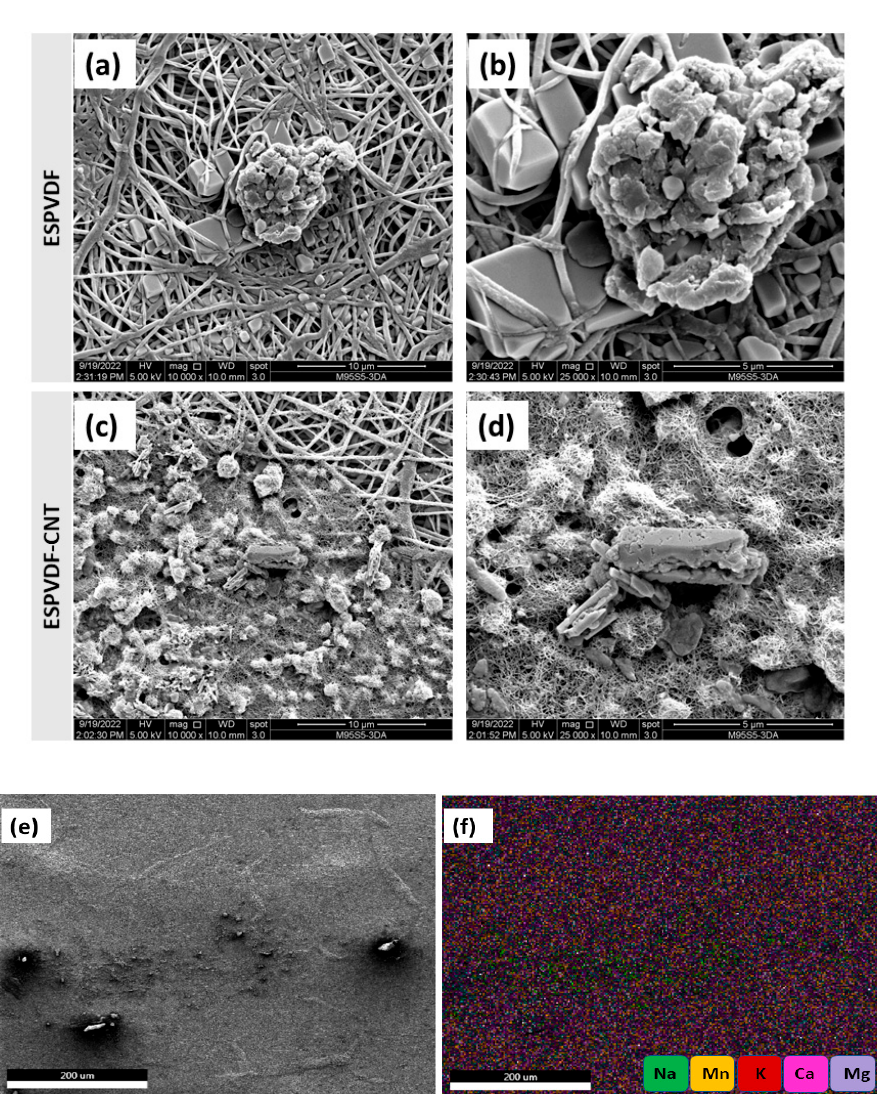
Figure 7. FESEM images of the electrospun PVDF-Co-HFP ( a , b ) and PVDF-Co-HFP-CNT ( c , d ) membranes after the 24-h DCMD operation, and the EDS images ( e , f ) of the CNT-modified PVDF-Co-HFP membrane after the MD process.